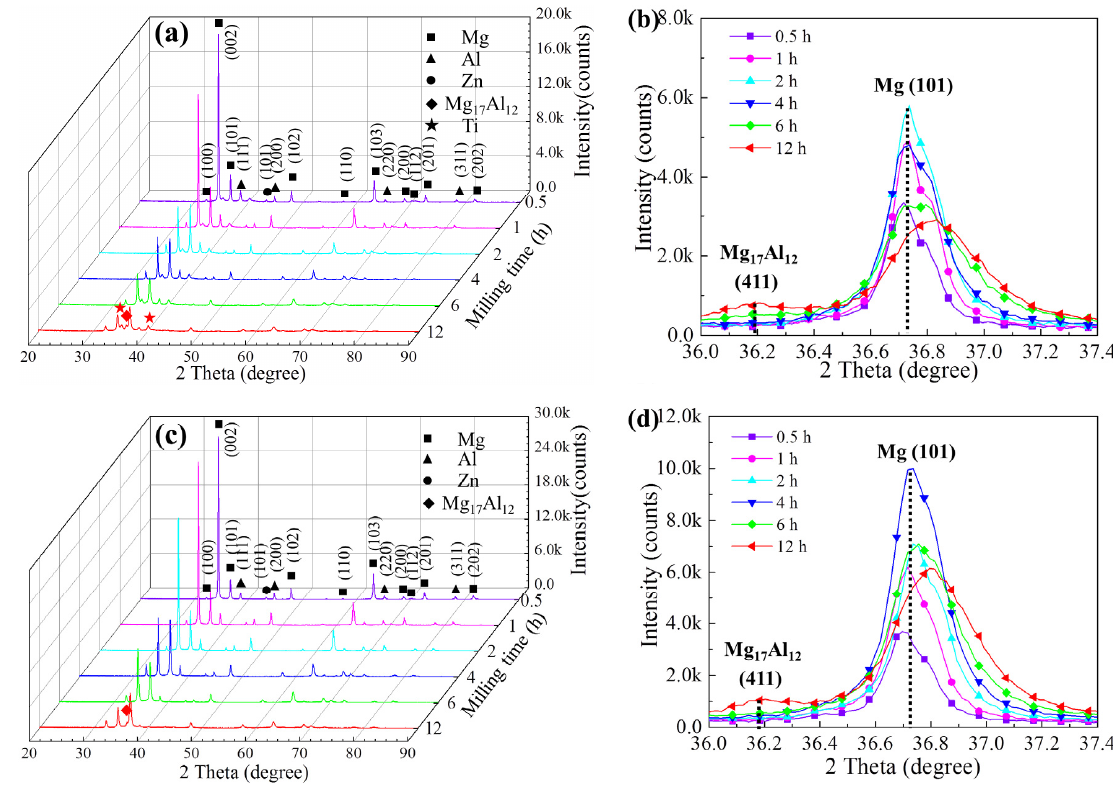
Figure 2. XRD patterns of the milled Ti/Mg-9Al-Zn-0.3Mn composite ( a , b ) and Mg-9Al-Zn-0.3Mn alloy ( c , d ) for various milling times.